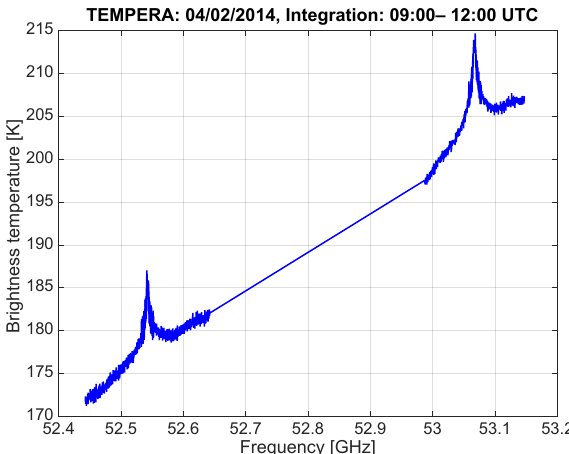
Figure 2. Spectrum of brightness temperatures measured with TEMPERA on 4 February 2014 from 09:00 to 12:00UTC. Only the FFT channels of the first line at 52.5424GHz and the second line at 53.0669GHz used in the temperature retrievals are